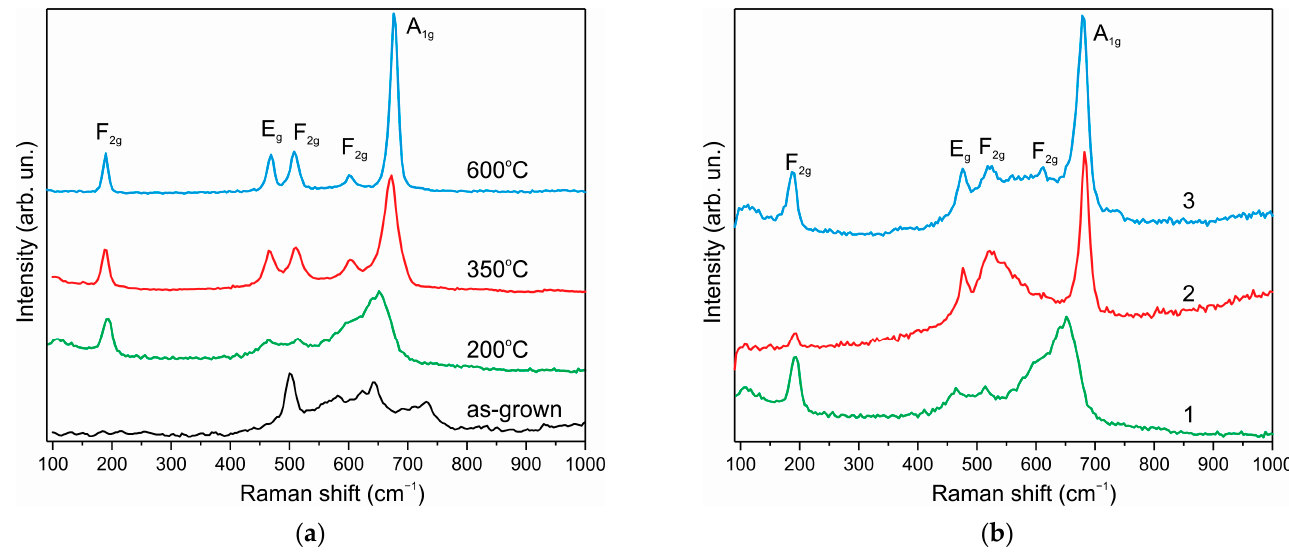
Figure 3. Raman spectra of Co 3 O 4 samples: ( a ) asgrown and annealed at 200, 350, and 600 °C in the air; ( b ) after synthesis annealed at 200 °C (1), after annealing in H 2 at 275 °C for 1 h (2), after measuring CV characteristics (3).